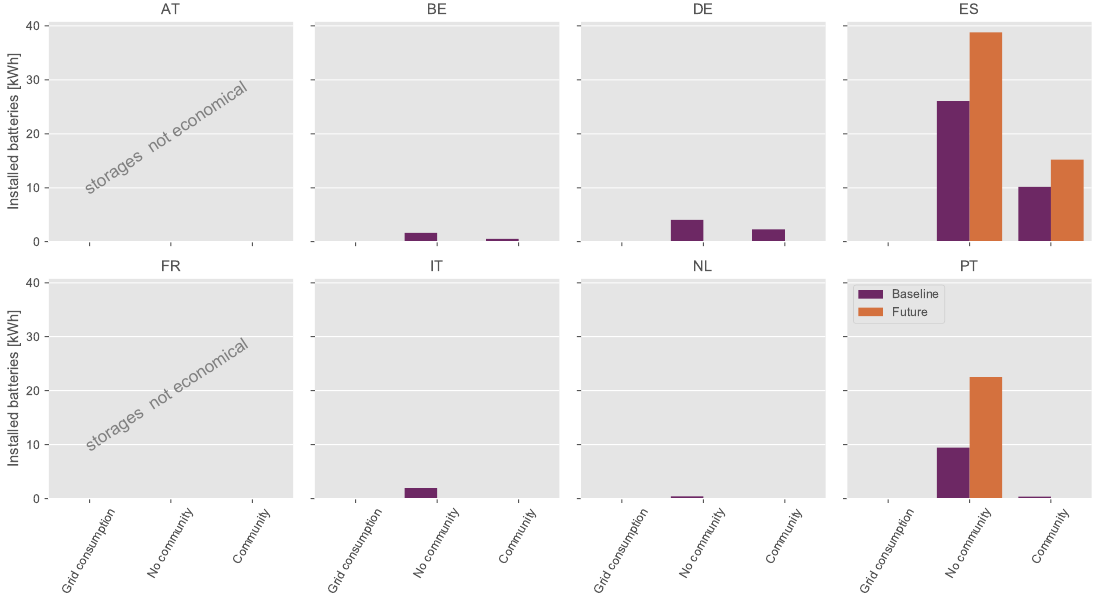
Figure 7. Investments into battery energy storage systems for all